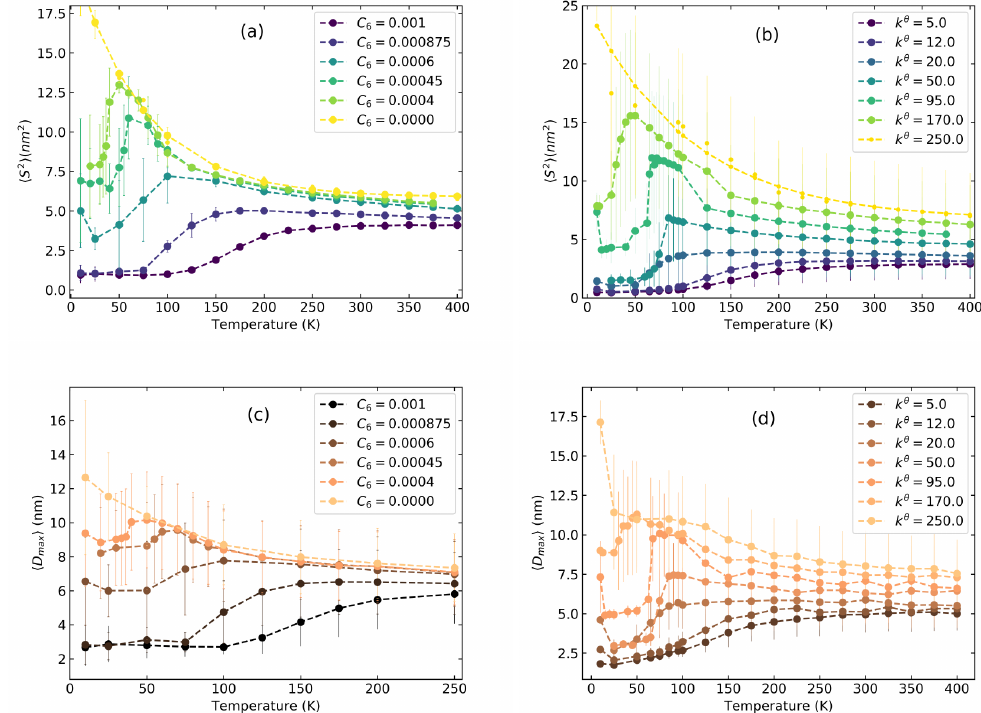
Figure 2. ( a ) Mean squared radius of gyration (cid:104) S 2 (cid:105) as a function of temperature for a LJ polymer with n = 200. The stiffness is tuned by the non bonded parameter C 6 in kJ the stiffness is tuned by varying the bending potential k θ in kJ between two monomers D max as a function of temperature for an LJ polymer where the stiffness is set by C 6 . ( d ) Similar to ( c ) but tuning the bending